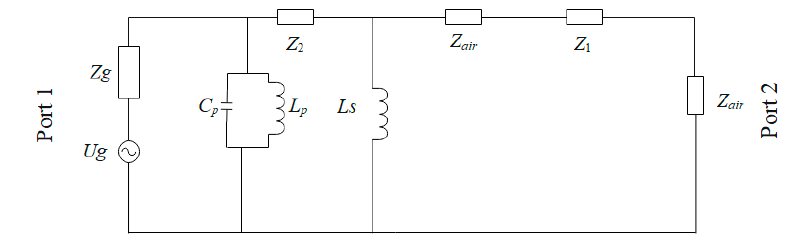
Table 2. PRS structure parameters. Figure 8. The equivalent circuit model (ECM) of the proposed FSS unit cell.